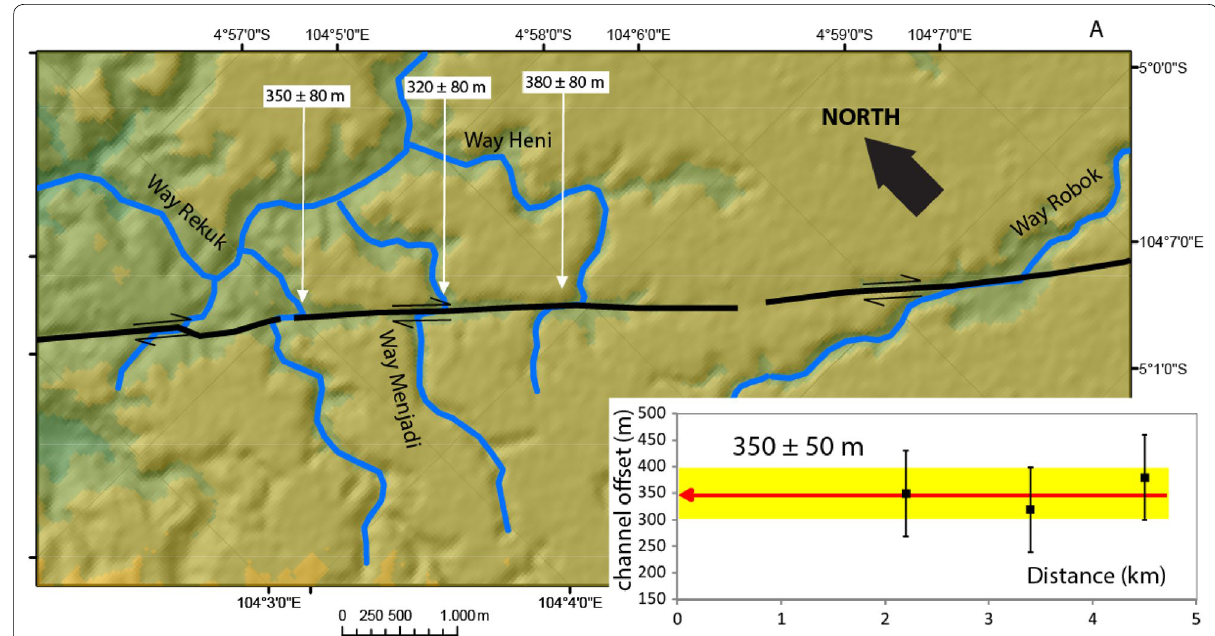
Fig. 11 Consistent right-lateral offsets of isochronous river channels deeply incised into the Ranau Tuff near Liwa. The total offset is estimated from three channels that cross the fault at high angle, and is consistent with the offset of channels that cross the fault trace at low angle. The digital ter- rain is developed from SRTM 1 Arc-Second. Location of these offsets is marked in Fig.